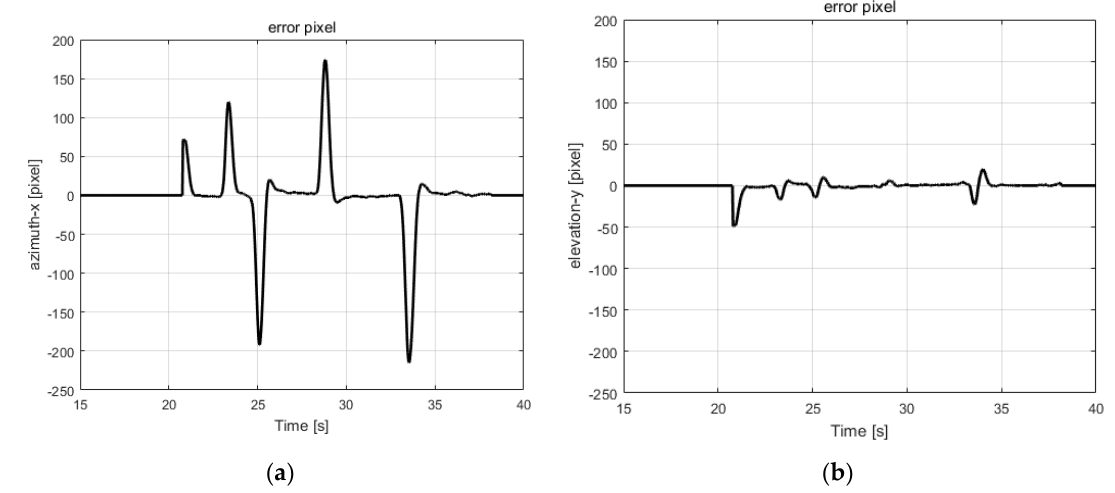
Figure 16. Boresight error in pixels during ground step tests. ( a ) the response of the gimbal system in azimuth; ( b ) the response of the gimbal system in elevation.